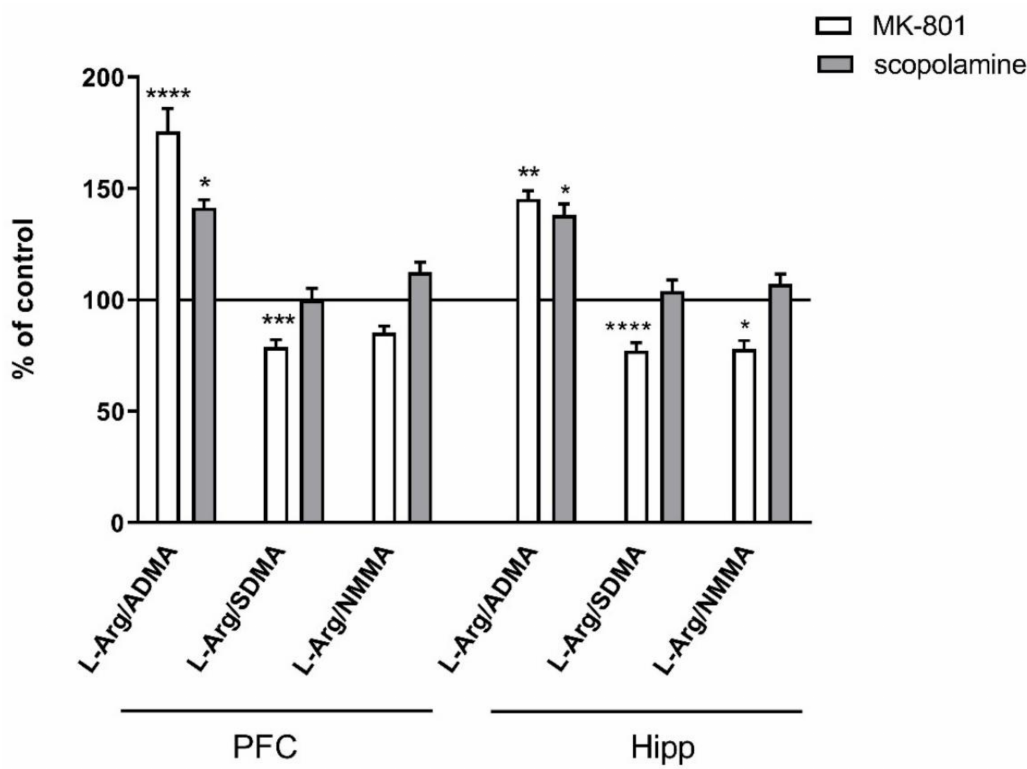
Figure 3. L-arginine (L-Arg)/ADMA, L-arginine/SDMA and L-arginine/NMMA ratios in the prefrontal cortex (PFC) and hippocampus (Hipp) after acute administration of MK-801 (0.3 mg/kg) or scopolamine (1 mg/kg). Data are presented as means ± SEM. * p < 0.05; ** p < 0.01; *** p < 0.001; **** p < 0.0001 vs.